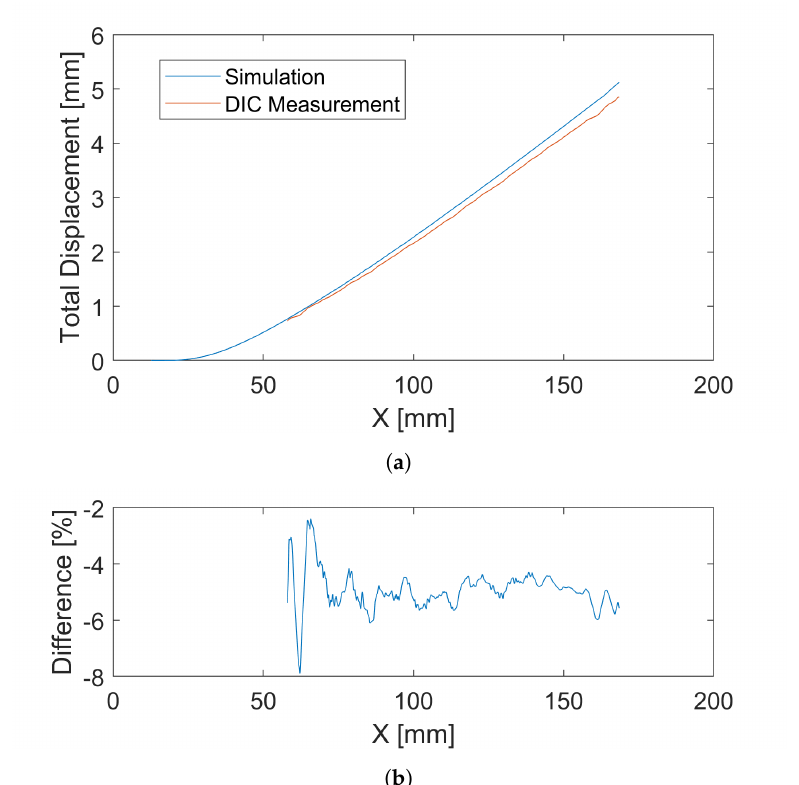
Figure 25. ( a ) Comparison of the experimental and numeric results for the displacements along a blade chord; ( b ) Percentage difference between the two